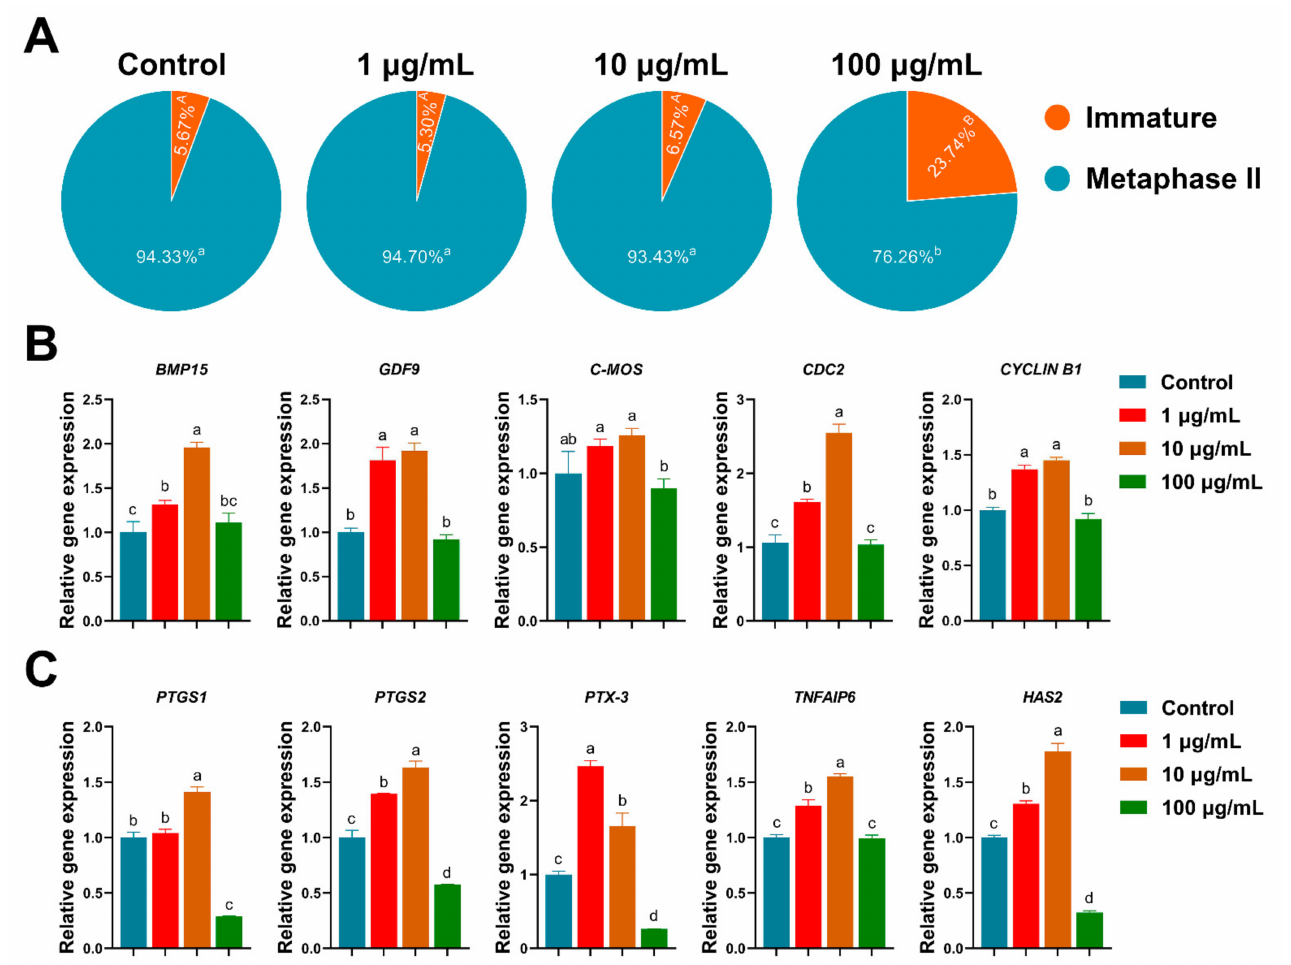
Figure 2. The effects of TA on the nuclear maturation of porcine oocytes and gene expression of oocytes and cumulus cells. ( A ) A total of 3239 oocytes were used in 19 independent replicates for evaluating nuclear maturation. ( B ) Oocyte developmental genes expression (GDF9, BMP15, C-MOS, CDC2 and CYCLIN B1). ( C ) Cumulus expansion genes expression (PTGS1, PTGS2, PTX-3, TNFAIP6 and HAS2). Within the same mRNA, bars with different letters denote significant differences ( p < 0.05). Results are shown as the average ± SEM of at least three repeats of independent